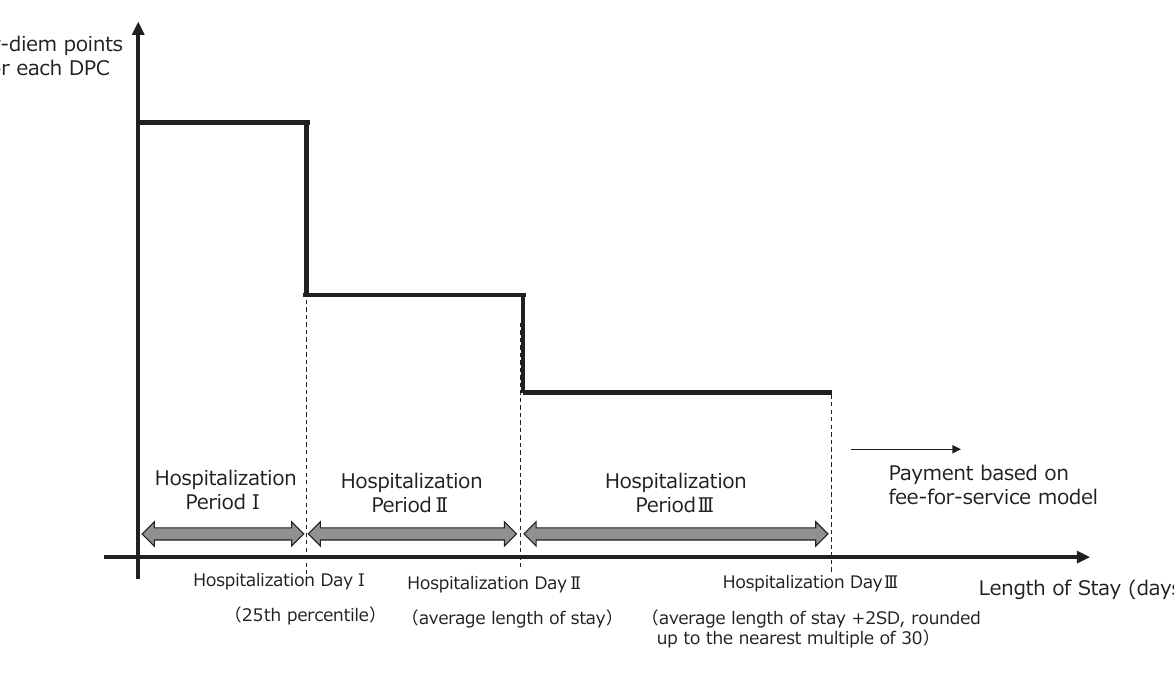
Figure 3. Method of setting the medical service fee points by the length of hospital